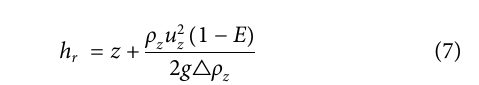
Frontiers in Earth Science |